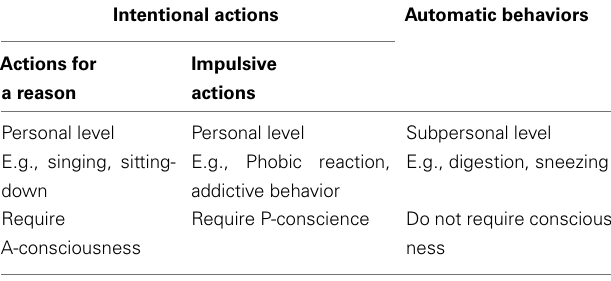
Table 2 |The Platonic conception of